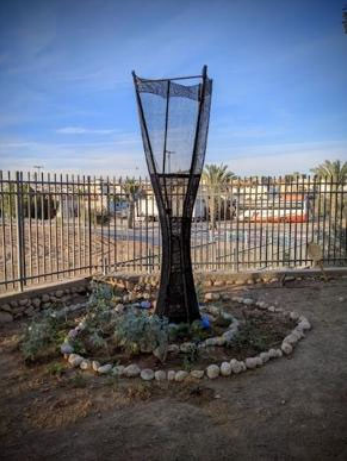
Figure 18. Rujum Transforms to Water Harvesting Sculpture, permanent installation in the school yard, Kuseife, 2021. Photographed by Dan Farberoff. Image courtesy of the artist.